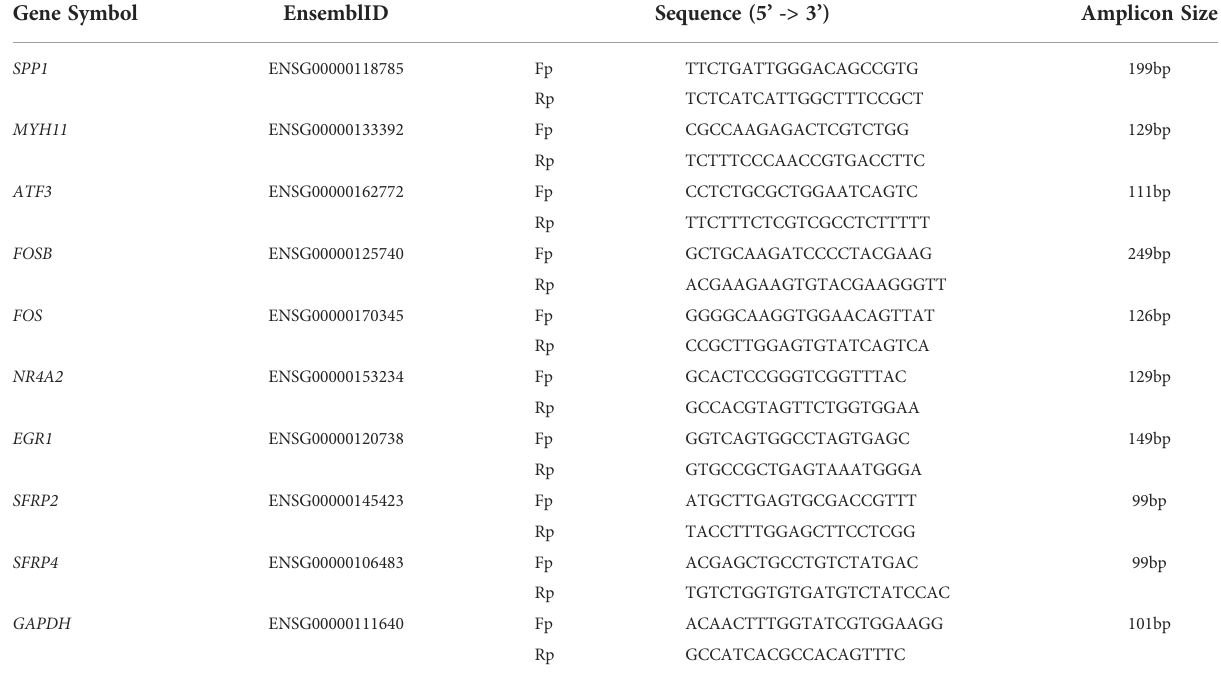
TABLE 3 Primers for real-time quantitative